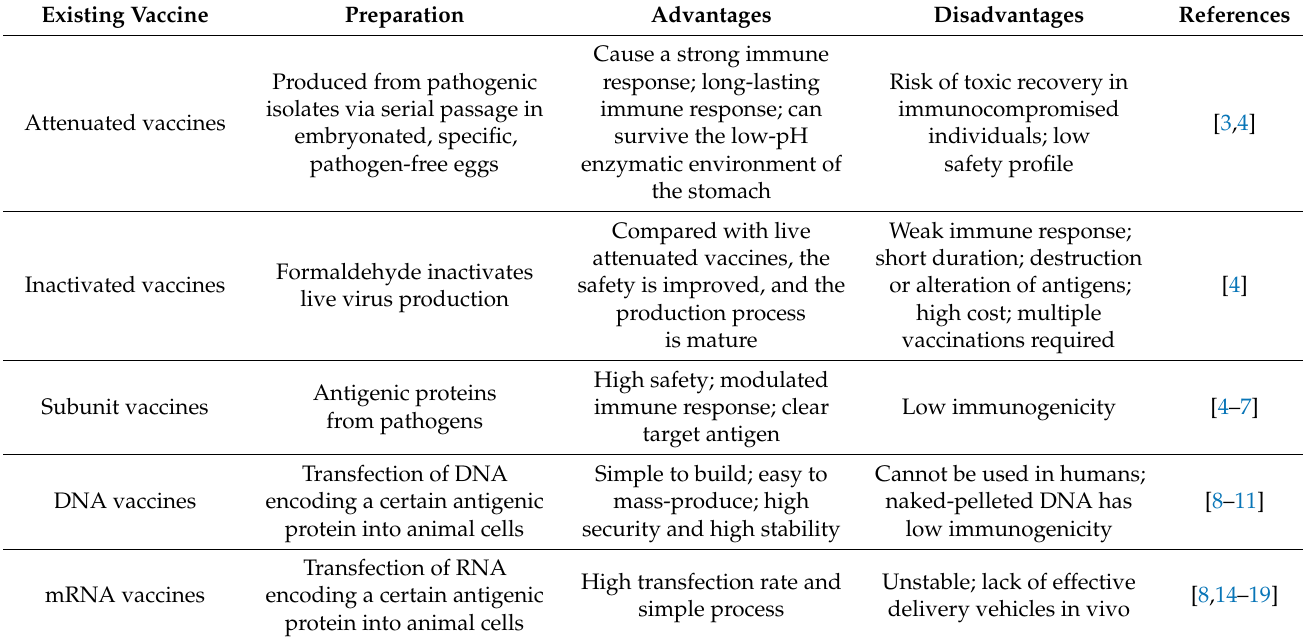
Table 1. Preparation, advantages, and disadvantages of existing